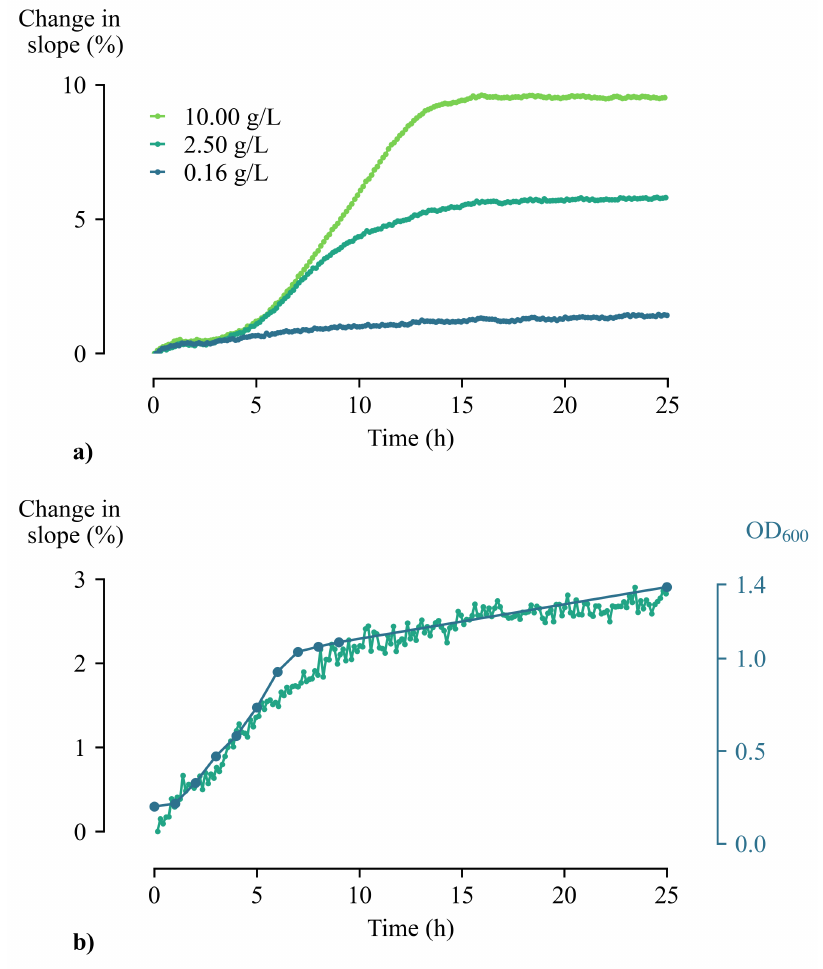
Figure 5. ( a ) Relative percentage change of slopes of Saccharomyces cerevisiae proliferated in growth medium with varying glucose concentration. It is clear that the slope of the sensor temperature response is influenced by the amount of available nutrients. ( b ) OD 600 measurements (blue) were performed in parallel to verify the results from the thermal measurements (green).